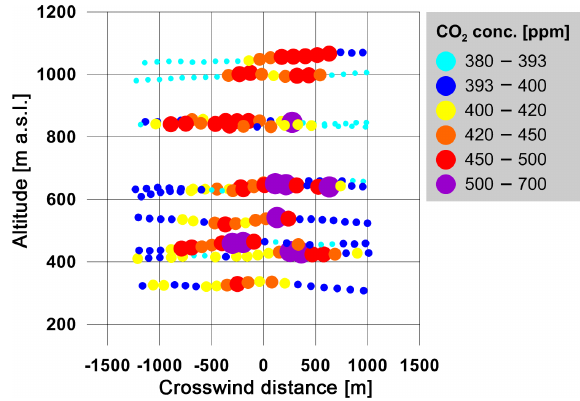
Figure 3. Details of the cross section through the plume of Nieder- außem (S1). The projected CO 2 concentrations (1 dot per 3s- average, i.e. about every 120m) are colour coded. It is important to average the fluxes along the wind, i.e. all values have to be projected to an imaginary cross section perpendicular to the wind and not par- allel to the flight pattern (see Fig. 2 and main text). The background concentration was determined to be at about 392 to 393ppm, which is a small uncertainty compared to the maximum plume concentra- tions of about +